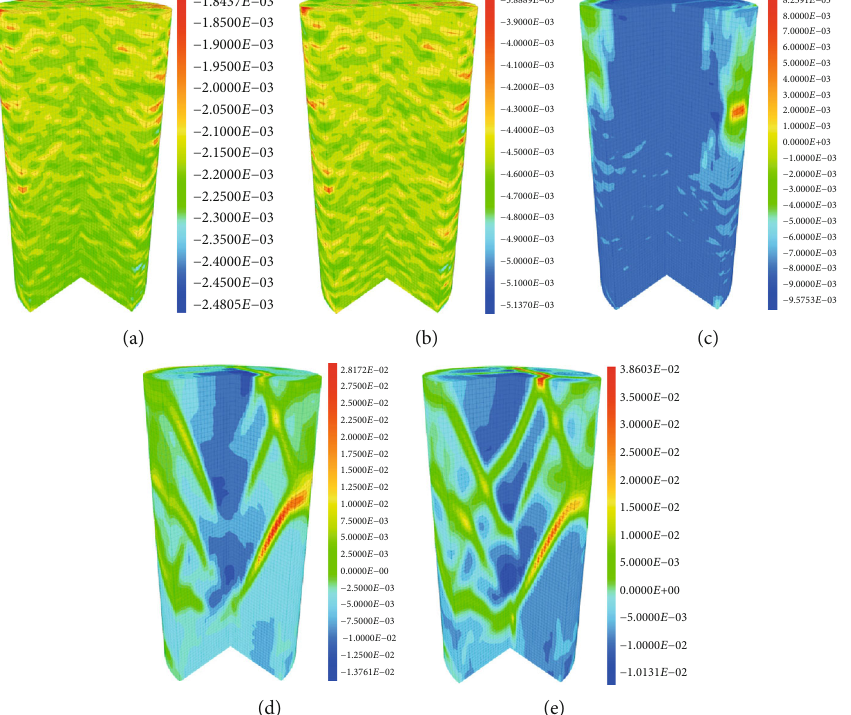
Figure 13: Evolution of volumetric strain for simulated HM coupled test: (a) initial compressed stage, (b) elastic stage, (c) peak stress point, (d) stress drop stage, and (e) residual